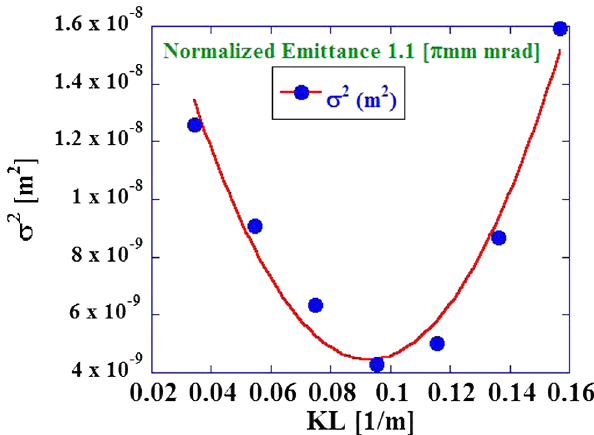
FIG. 11. Beam emittance measured by the Q -scan method at the position after BC3. The measured normalized emittance is 1 : 1 (cid:5) mm mrad